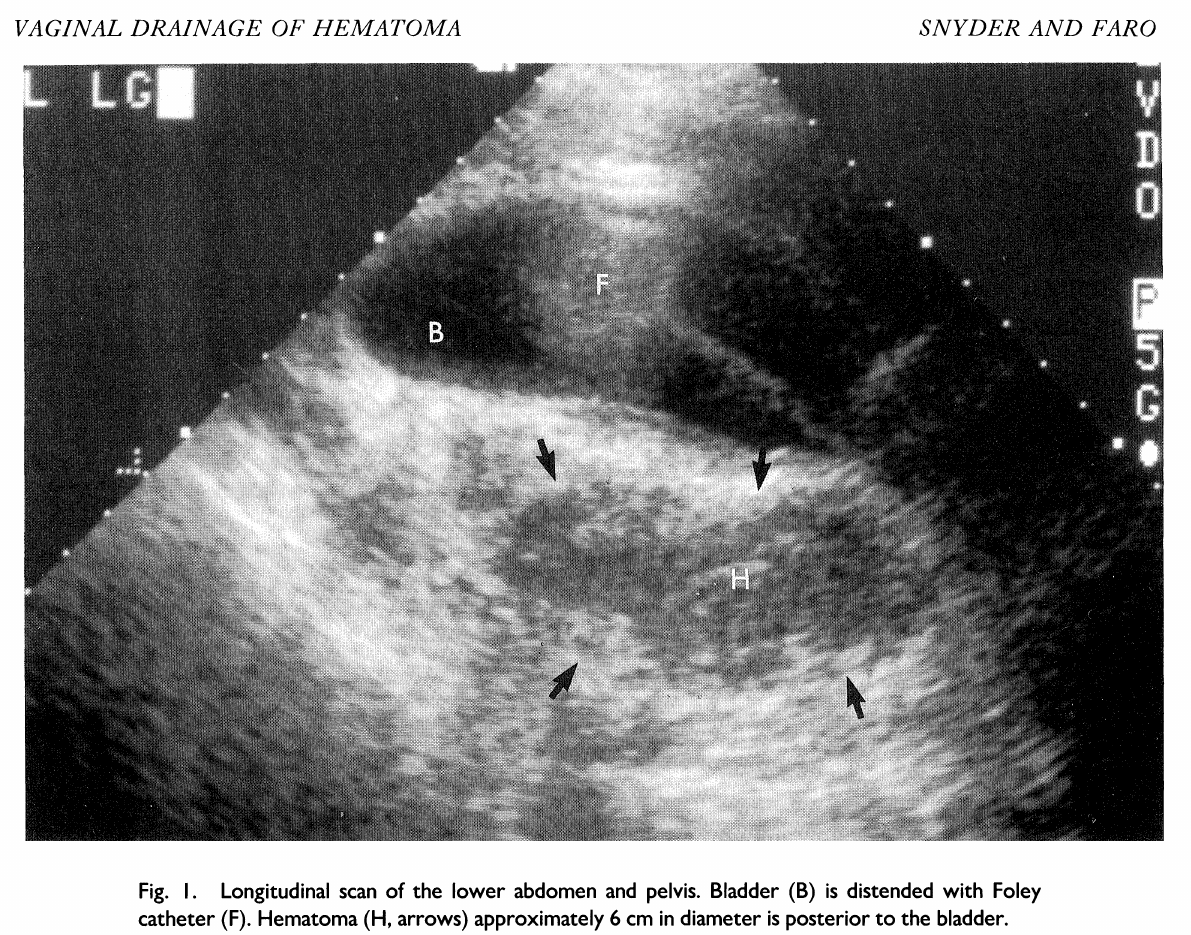
Fig. I. Longitudinal scan of the lower abdomen and pelvis. Bladder (B) is distended with Foley catheter (F). Hematoma (H, arrows) approximately 6 cm in diameter is posterior to the